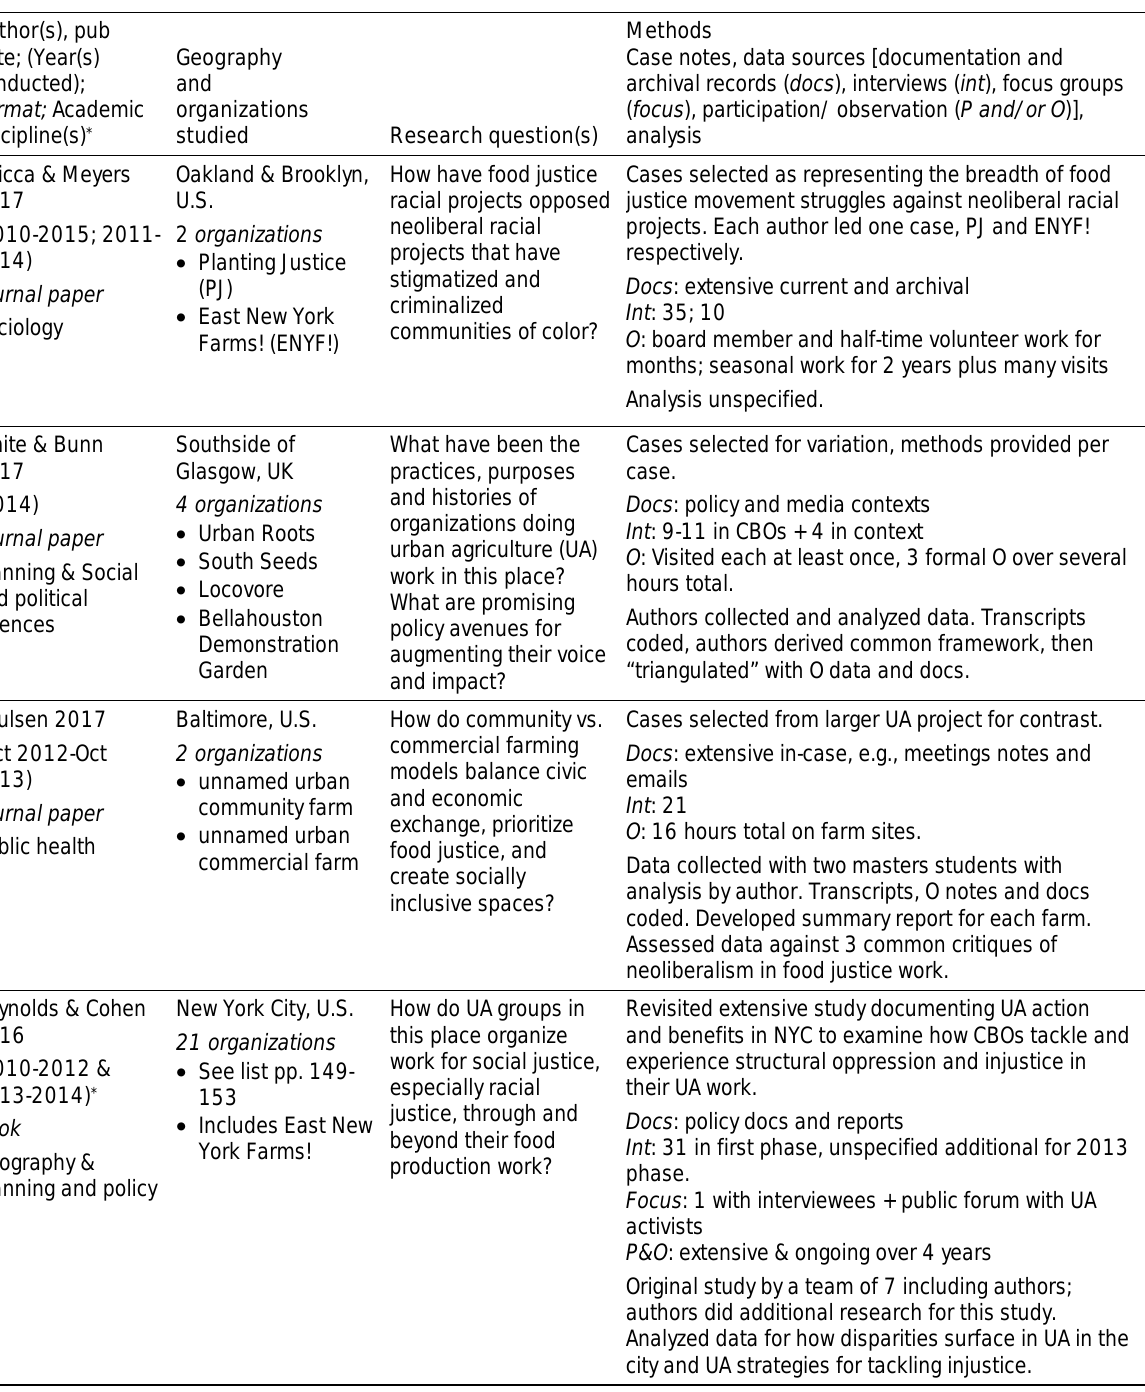
Table 1. Purposes and Case Study Methods Used with Food System CBOs in 11